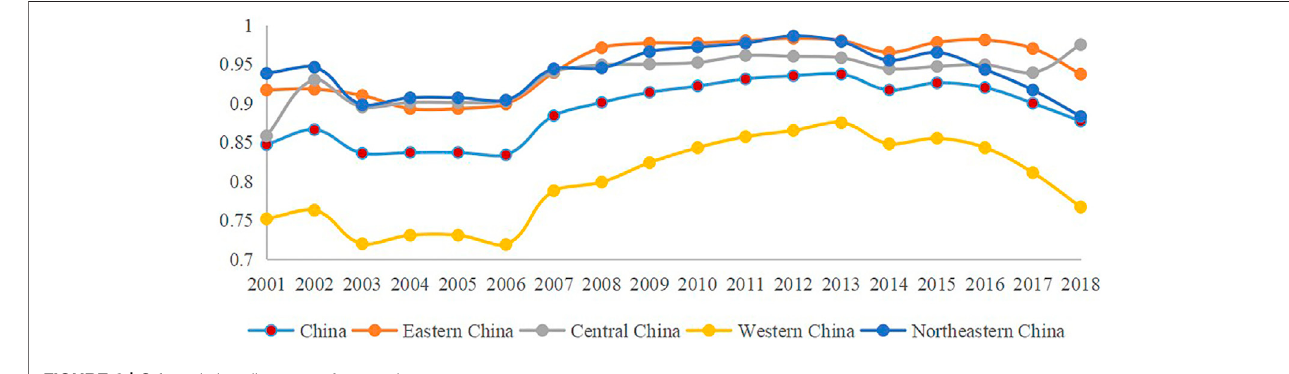
FIGURE 2 | Gtfp variation diagram at four